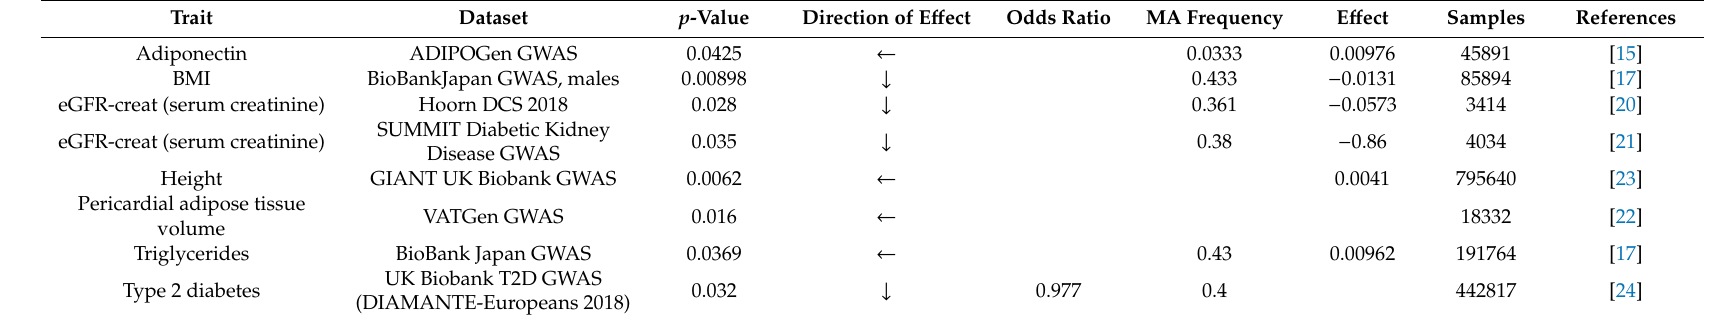
Table 8. Association of rs9292806 across all datasets and traits included in the Type2Diabetes knowledge